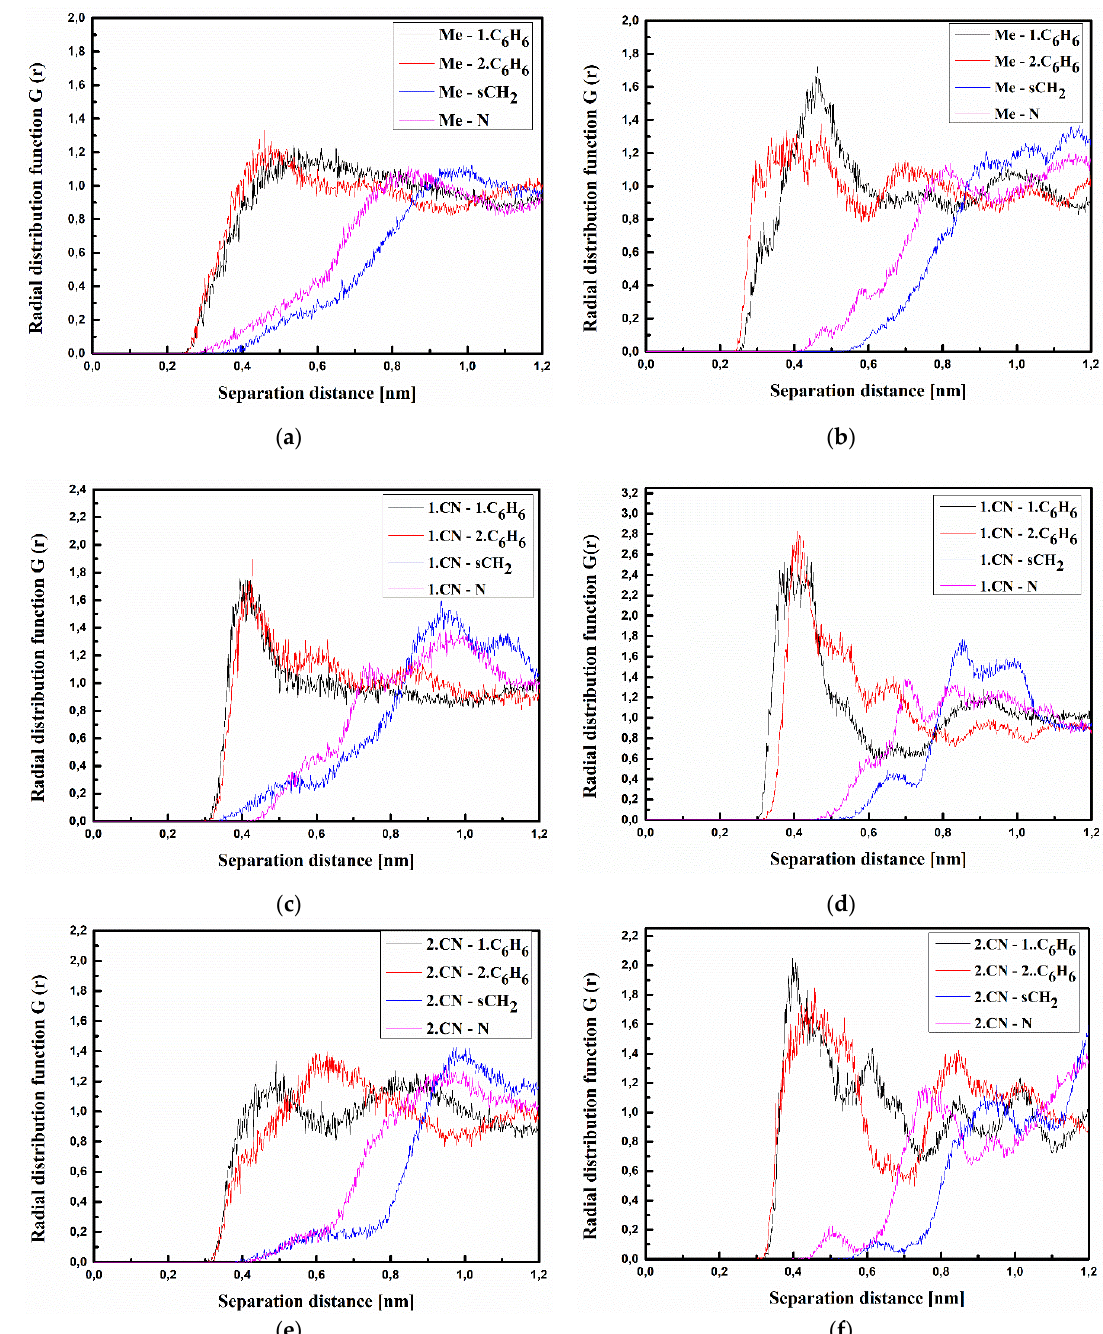
Figure 3. Partial RDFs calculated for distances between the center of mass of different moieties of the A molecule and different subunits of PVK at T = 500 K ( a , c , e ) and T = 300 K ( b , d , f ) for the bulk system. The RDFs are presented for the methyl group (Me) of the A molecule and different subunits of PVK mer ( a , b ); for cyanovinyl CN1 at the side of the molecule A and different subunits of PVK mer ( c , d ); and cyanovinyl CN2 at the back of the molecule A and different subunits of PVK mer ( e , f ).